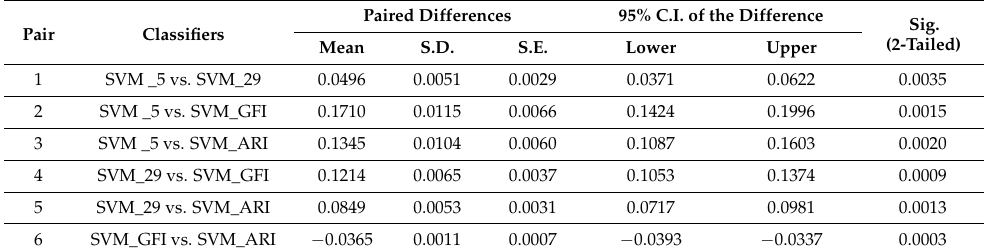
Table 5. Paired sample t test of the accuracy of SVM classifiers.